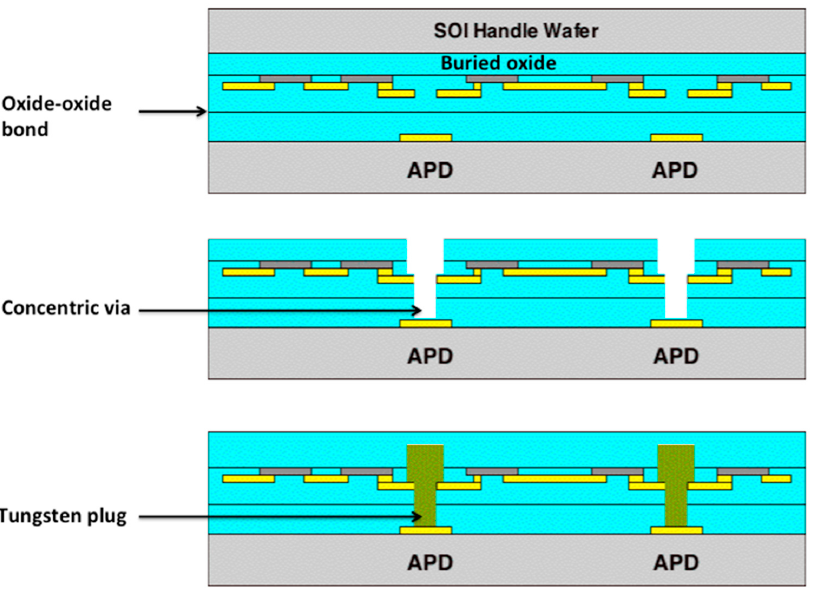
Figure 4. Steps in the Lincoln 3D-integration process to integrate the APD wafer (tier 1) with the first SOI CMOS wafer (tier 2).